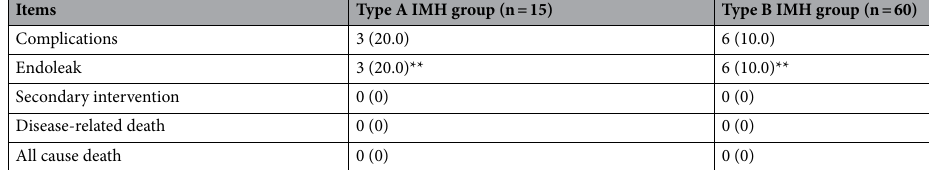
Table 13. Follow-up of patients undergoing endovascular treatment [example (%)]. **Are all type I internal leaks.